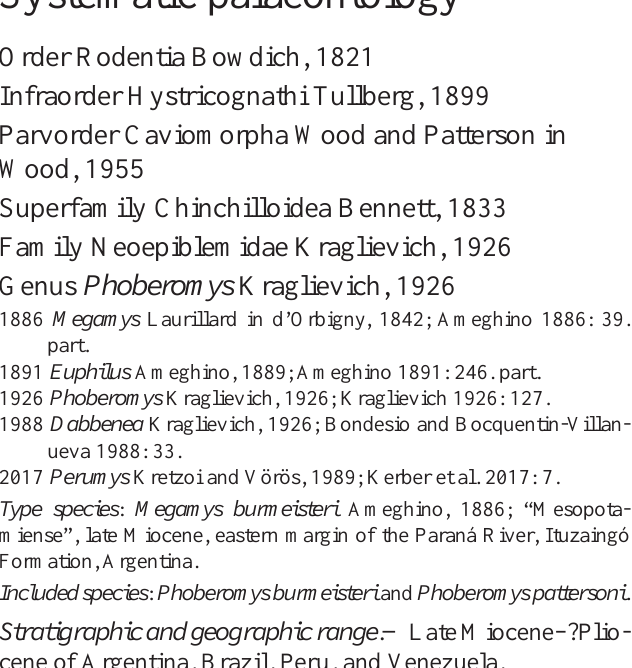
Material .—MHNC-MS-001, left mandibular fragment with incisor (portion) and p4 (portion)–m3, from Monte Salvado Native Community, Madre de Dios Department, Peru. Although found as float, based on its matrix, this specimen most likely originates from the lower unit of the Madre de Dios Formation, late Miocene in age (see Geological setting).